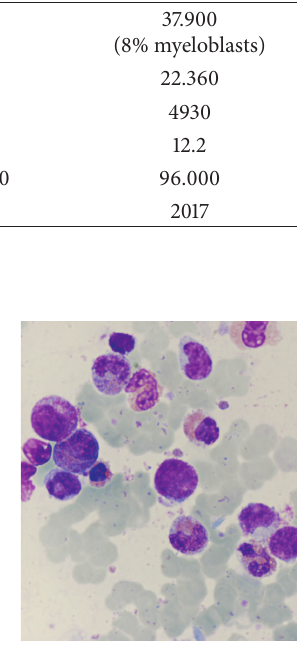
Figure 1: Bone marrow aspirate at relapse showing infiltration by myeloblasts, left shifted granulopoiesis, and marked hypere-